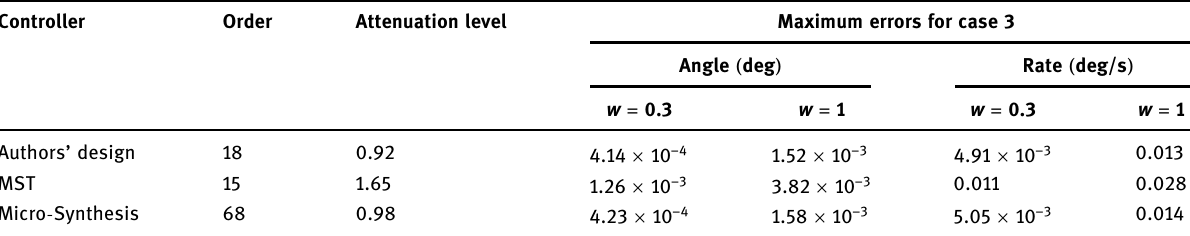
Table 5: Features of the controllers